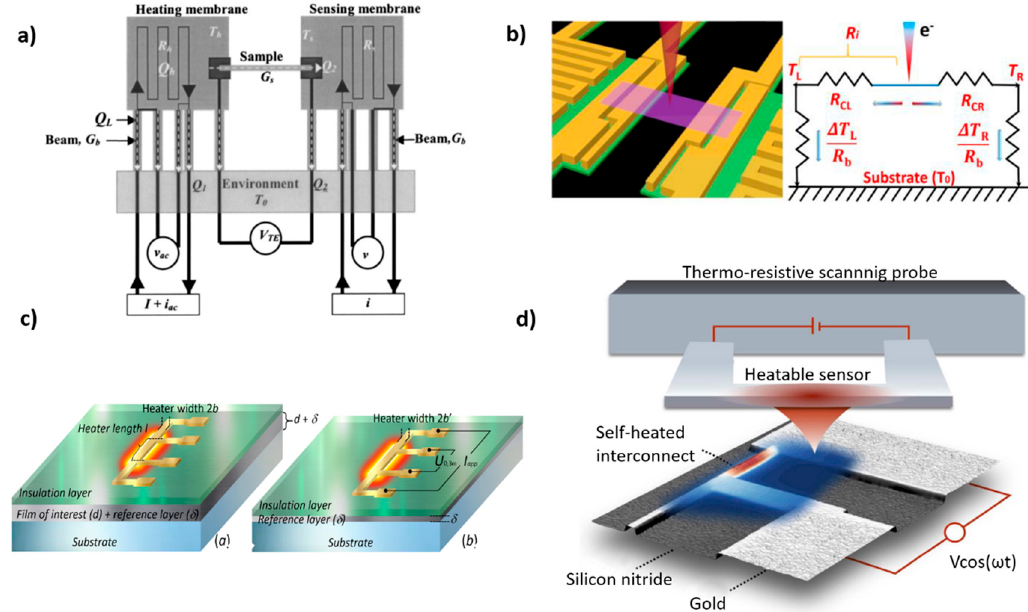
Figure 7. Electrical thermal characterization techniques. Schematic representations and thermal resistance circuits of ( a ) the electro-thermal bridge and ( b ) the electron beam self-heating technique. ( a ) Reproduced with permission from [107]. Copyright The American Society of Mechanical Engineers, 2003. ( b ) Reproduced with permission from [124]. Copyright Elsevier B.V., 2018. ( c ) Schematic of a three-omega heater deposited on a sample of interest with thickness d and small reference of thickness δ (left image) and a reference sample with thickness δ (right image). ( d ) Schematic illustration of the dual-sensing technique applied in a self-heated gold interconnect. Reproduced with permission from [159]. Copyright Nature Springer, 2016.